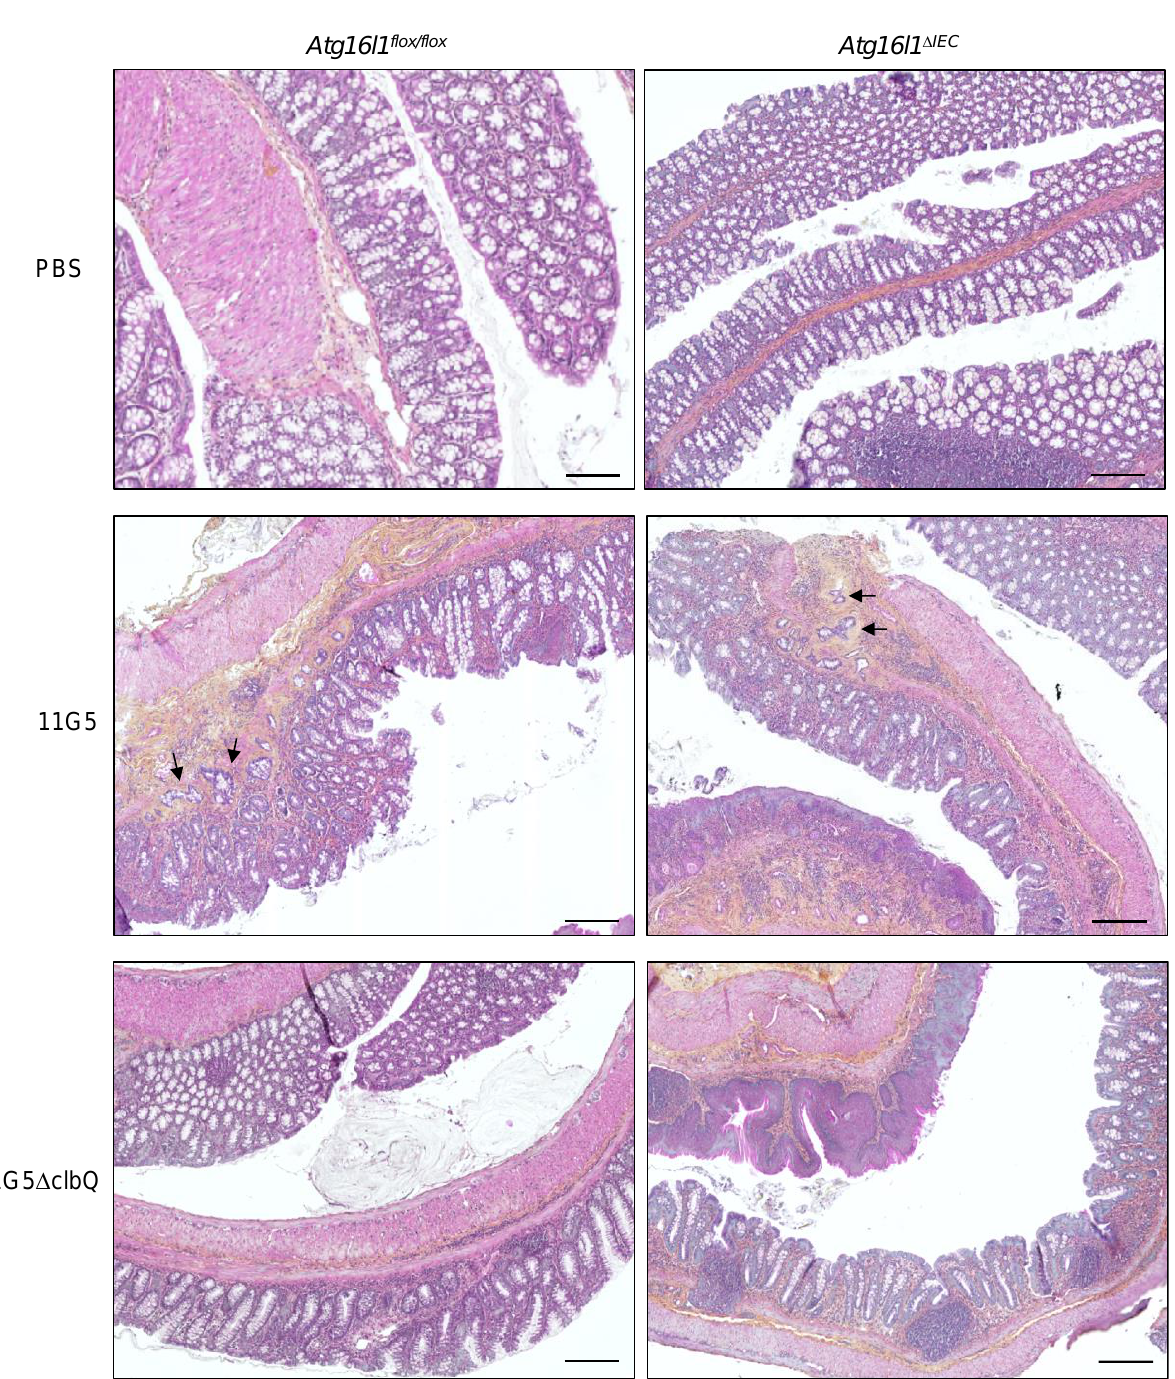
Figure 3. CoPEC infection triggers the formation of invasive adenocarcinomas in a mouse model of chronic DSS treatment, and this was further enhanced by autophagy deficiency in IECs. Atg16l1 flox/flox and Atg16l1 ∆ IEC mice were treated with streptomycin for 3 days and then received water for 24 h before being orally administered (day 0) with PBS or with 10 9 colony-forming units of 11G5 bacteria or the mutant 11G5 ∆ clbQ. Seven days later, the mice were subjected to 12 cycles of DSS treatment. Sections of the colons taken at the sacrifice were H&E-stained. The images are representatives of N = 10 mice/group for +PBS and 11G5-infected conditions, and N = 6 mice/group for 11G5 ∆ clbQ-infected condition. Black arrows show invasion of the glands through the muscularis mucosa. Bars = 200 µm.